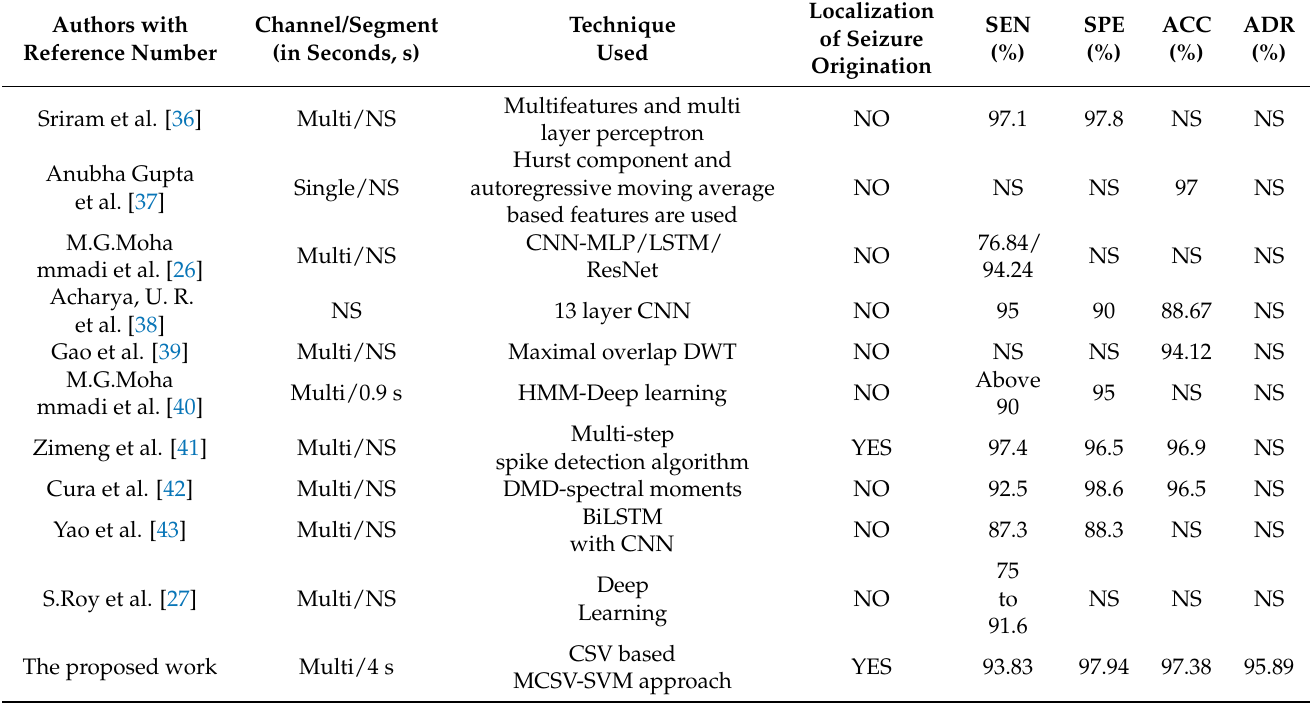
Table 3. A Summary of Literature Presenting Various Techniques for Epileptic Seizure